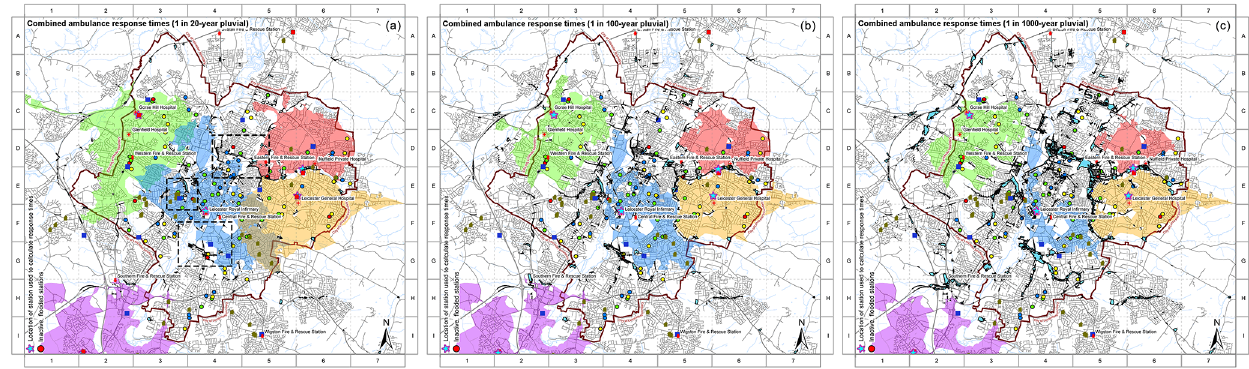
Figure 11. City-scale accessibility (within an 8min time frame) for ambulance service stations under (a) 1 in 20-year, (b) 1 in 100-year and (c) 1 in 1000-year surface water flooding scenarios. The key access roads referred to in the text are highlighted in the rectangles in Fig. 11a. Refer to Fig. 7 for